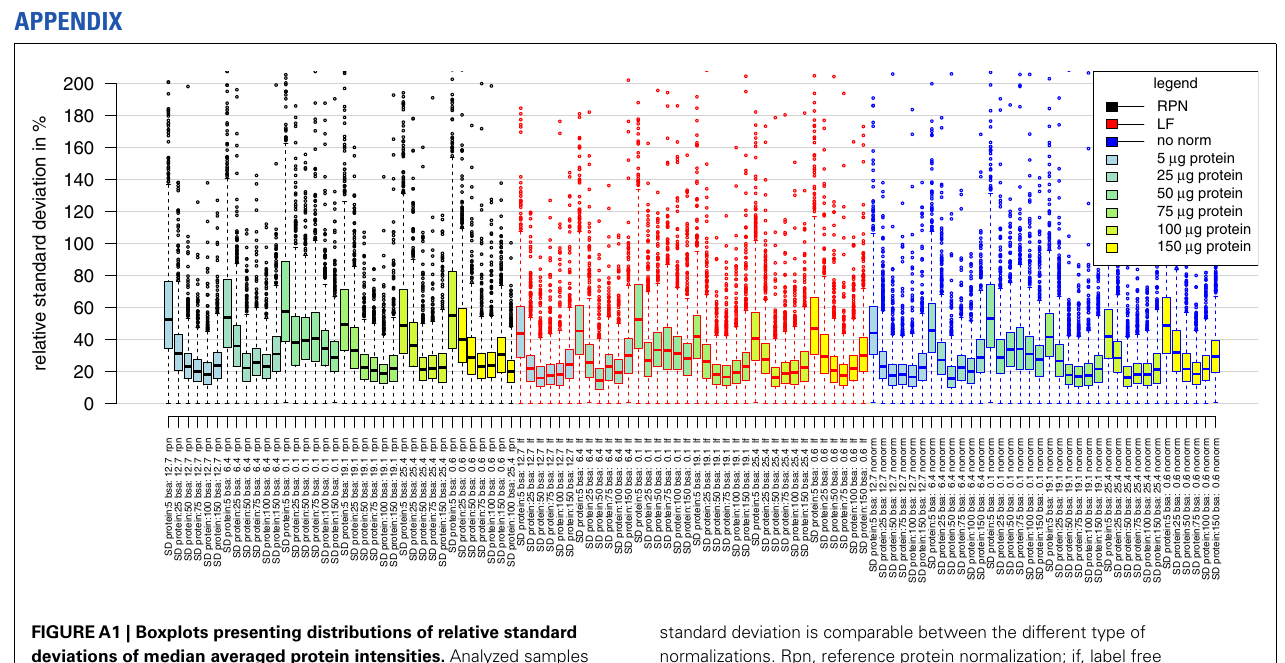
FIGUREA1 | Boxplots presenting distributions of relative standard deviations of median averaged protein intensities. Analyzed samples belong to the combinatorial matrix spiked with BSA (from 0.1pmol to 25pmol) in a protein background ranging from 5 µ g to 150 µ g. Distribution of